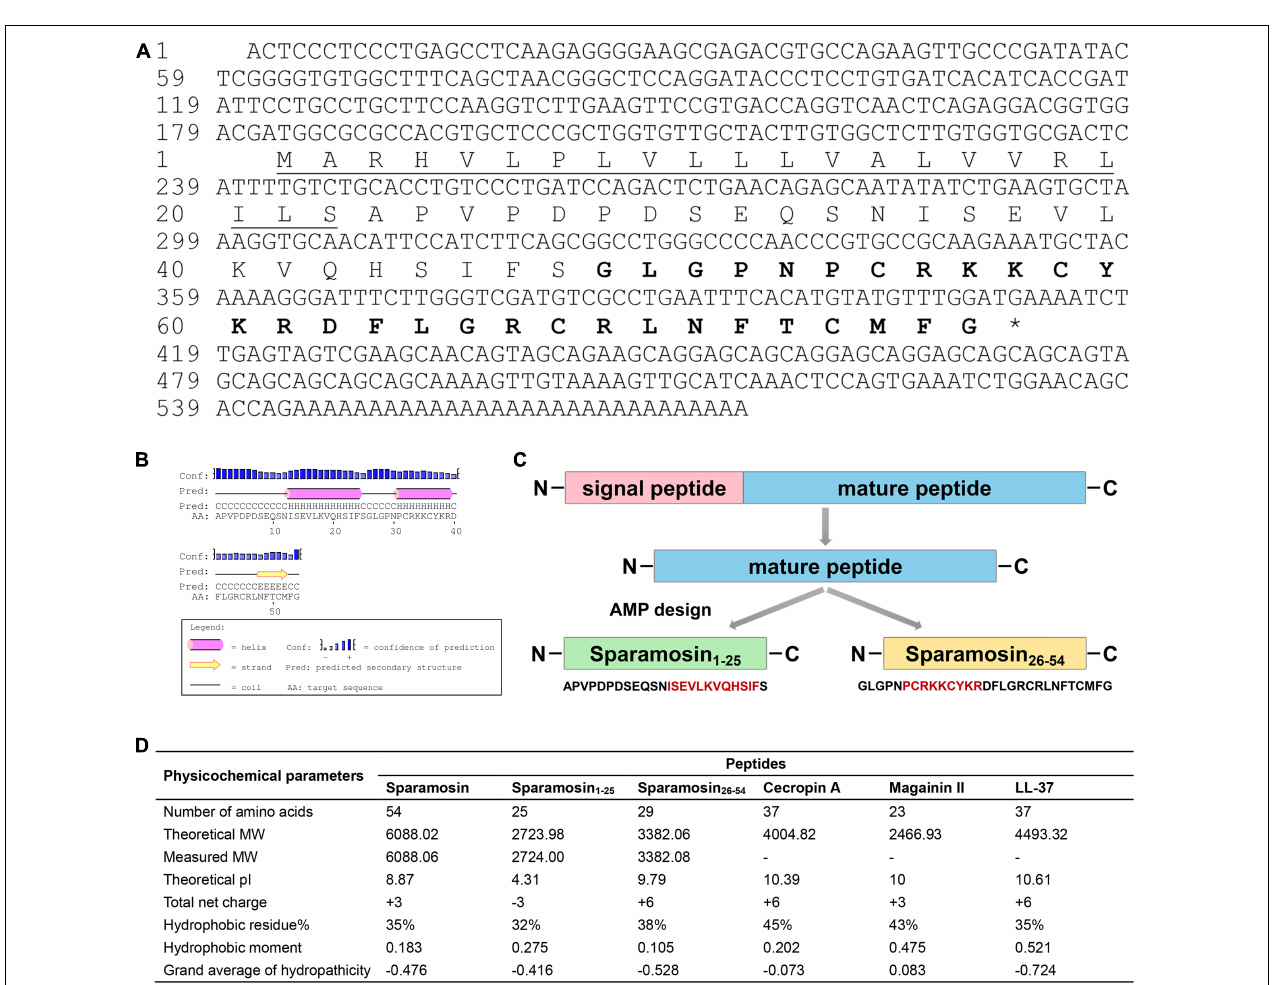
FIGURE 1 | Sequence analysis and peptide design process. (A) Full-length cDNA and deduced amino acid sequence of Sparamosin. The underline indicates the putative signal peptide. The amino acid sequence of Sparamosin 26 − 54 is shown in bold. The cDNA sequence has been deposited in GenBank and the accession number is MH423837. (B) The predicted secondary structure of Sparamosin mature peptide. There are two predicted α -helices located at residues Ile 13 -Phe 24 and residues Pro 31 -Arg 39 , respectively. (C) The design process of truncated peptide. The red amino acid sequence represents the predicted α -helix structure. (D)